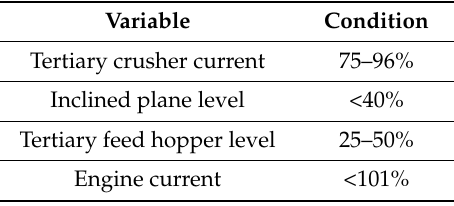
Table 7. Stability Band Ranges.